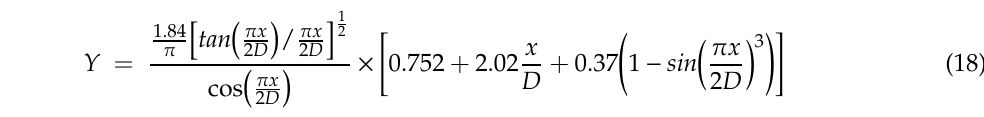
Figure 8. Model of steel wire with a pre-corroded defect at each mass loss rate: ( a ) η = 0.25%;